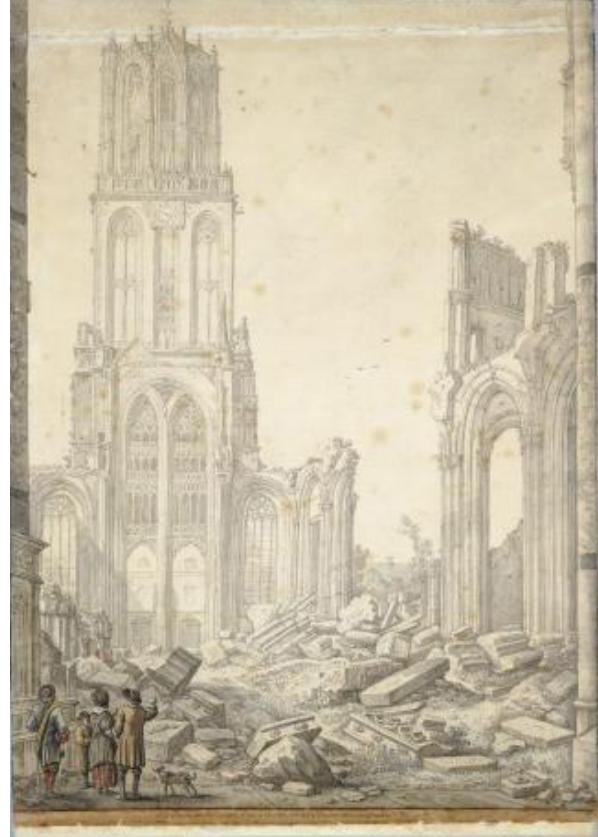
Figure 2. Drawing of the ruin of the Dom cathedral following the 1674 storm by Herman Saftleven (Utrecht City Archive no. 28635). The viewpoint of the artist is from the undamaged part of the Cathe- dral overlooking the area with the collapsed nave towards the Dom